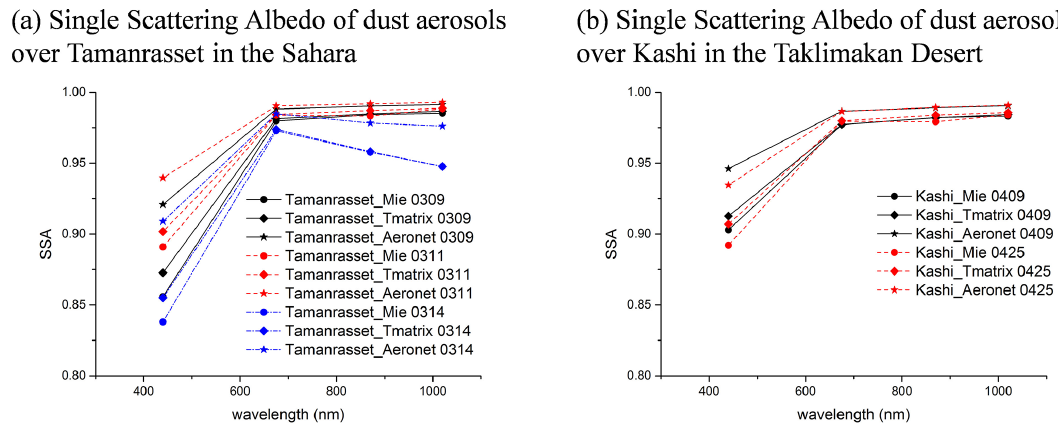
Figure 13. Single scattering albedo of dust aerosols over (a) Tamanrasset in the Sahara and (b) Kashi in the Taklimakan Desert.